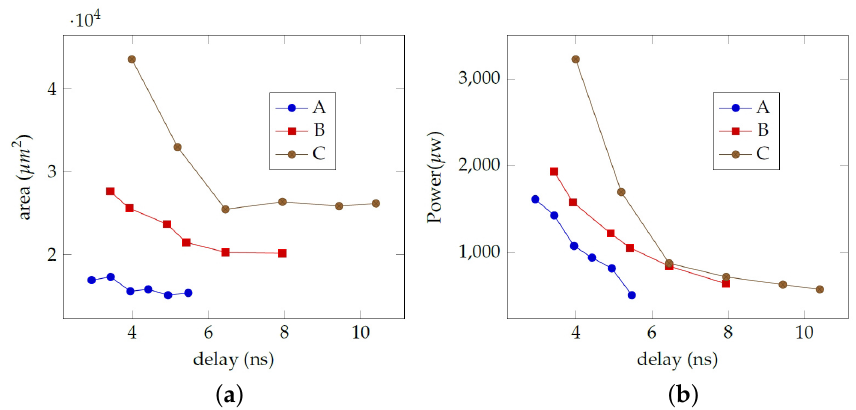
Figure 14. Area, delay and power complexity plots for a softmax layer of size 10, for the proposed and [22] circuits in the case of 10-bit wordlength implemented in a standard-cell library. A, B and C in the legends denote architectures in Figure 2a, Figure 2b and [22], respectively. ( a ) Area vs. delay plot. ( b ) Power vs. delay